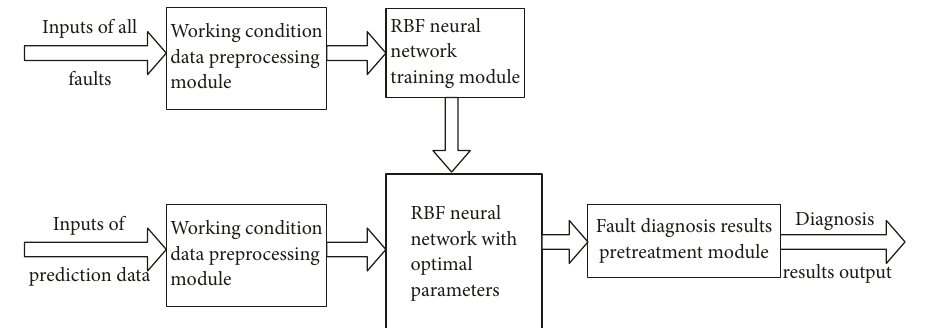
Figure 5: Structure of fault diagnosis model.